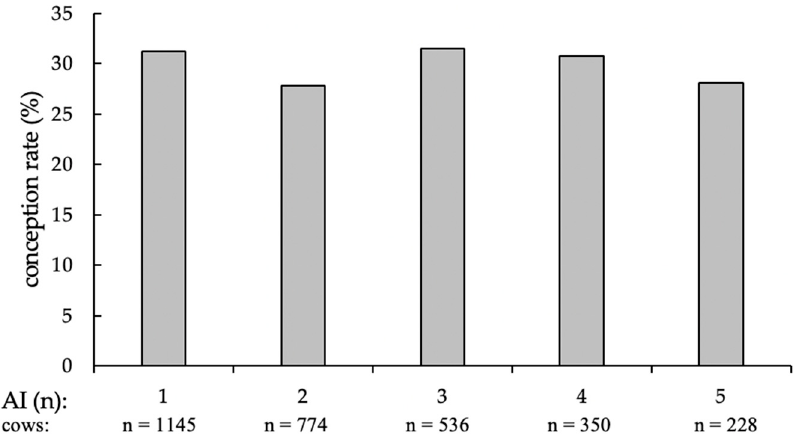
Figure 2. Conception rates of cows at first and additional AI (in %), separated by the number of AI and supplemented numbers of cows per group.